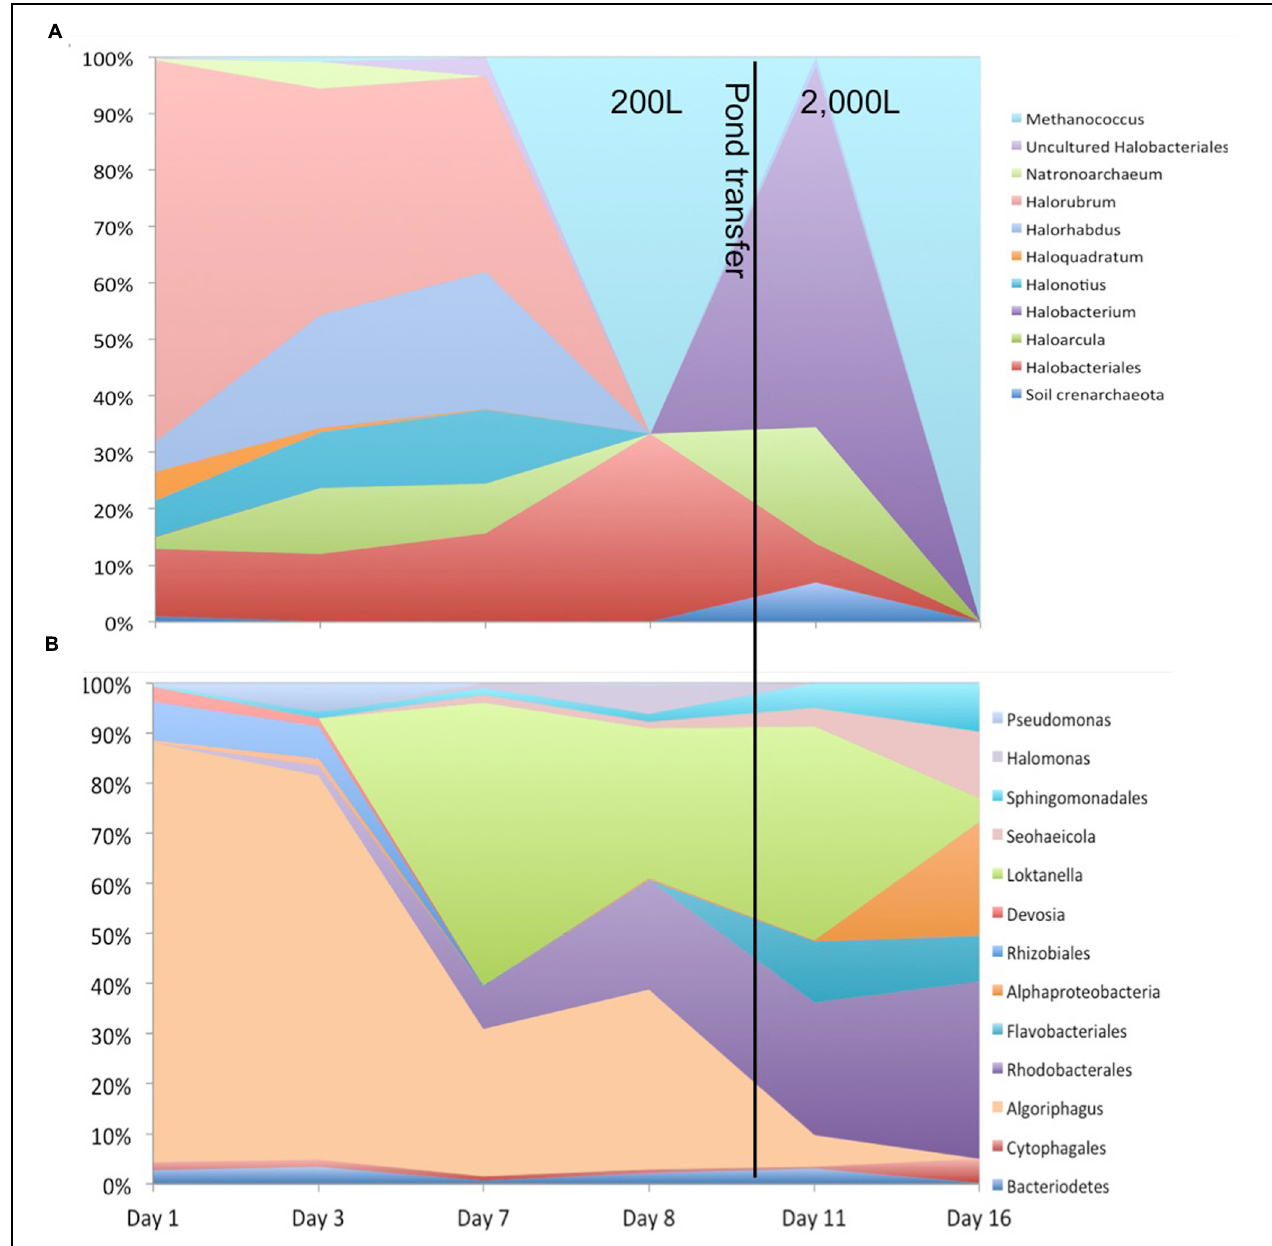
FIGURE 1 | Total relative abundances of (A) archaeal and (B) bacterial taxa by order (as order, genus, or unknown) with > 2% relative abundance over the 16 day sample